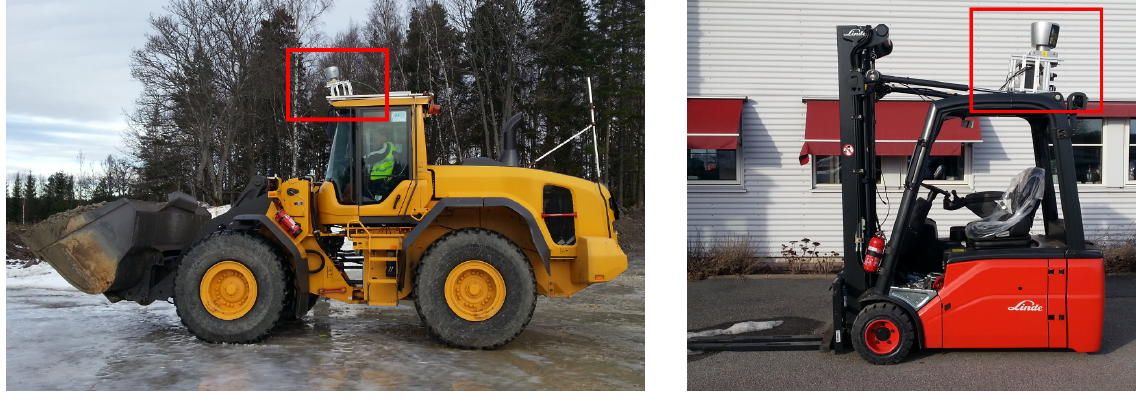
Figure 10. Industrial vehicles on which the camera setup was mounted for the experiments: Wheel loader ( left ) and forklift truck ( right ). The location of the sensor unit with NIR stereo camera and 3D laser scanner (for ground truth data acquisition) is indicated in